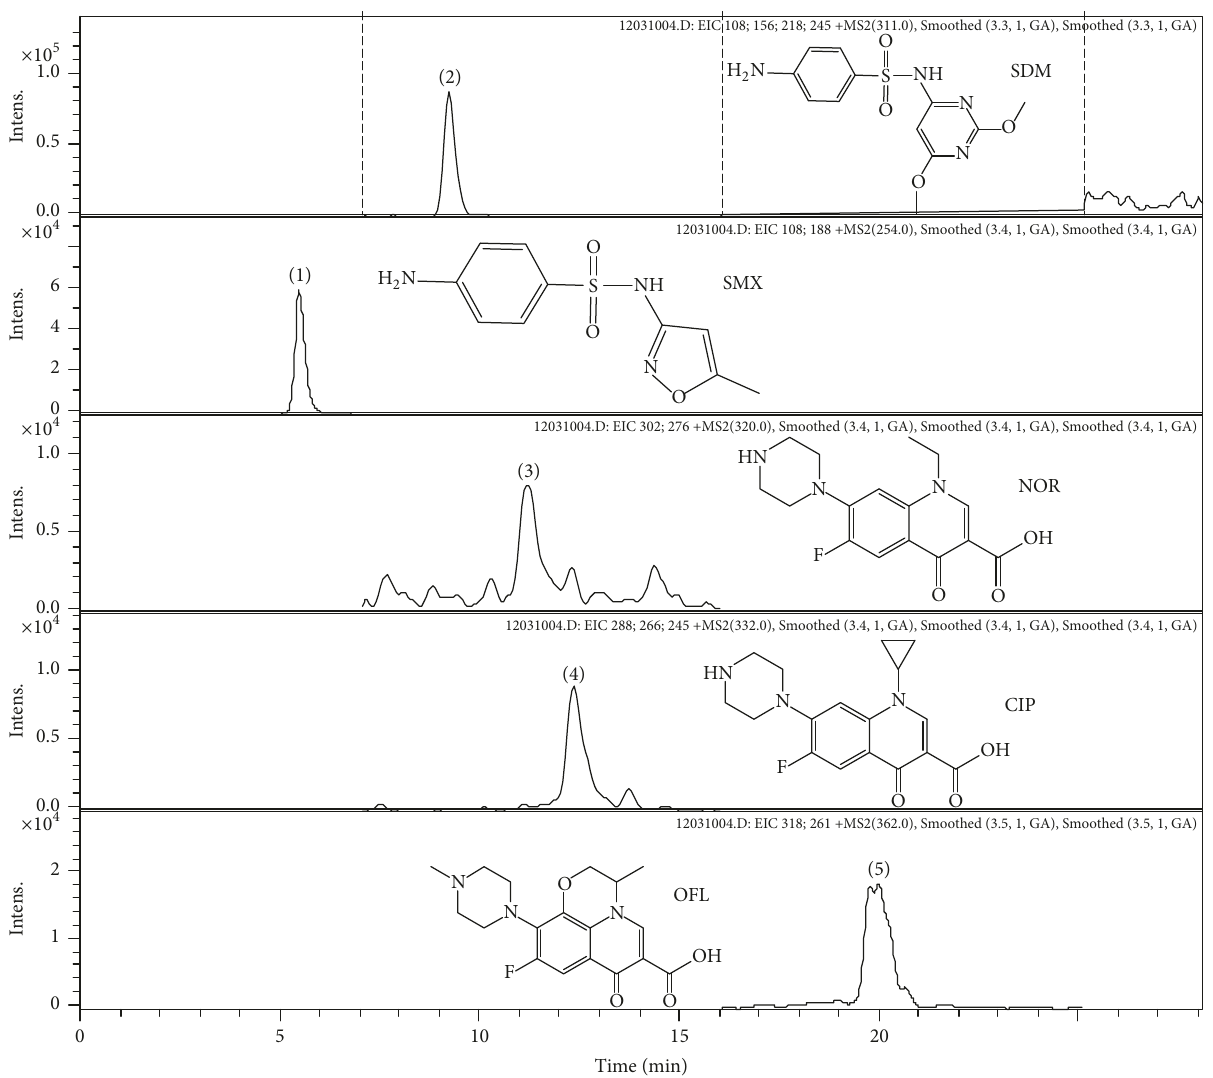
Figure 1: The chromatographic separation of antibiotic residues in potato tuber. Antimicrobials spiked in the LoQ level ((1) SMX 32.7 ng/g; (2) SDM 17.8 ng/g; (3) NOR 40.0 ng/g; (4) CIP 27.2ng/g; (5) OFL 5.0 ng/g). Eluent: 5 mM HFIP (pH 9) and MeOH. Analytical column: Waters XBridge C18 column (150mm × 3 mm, 3.5 𝜇